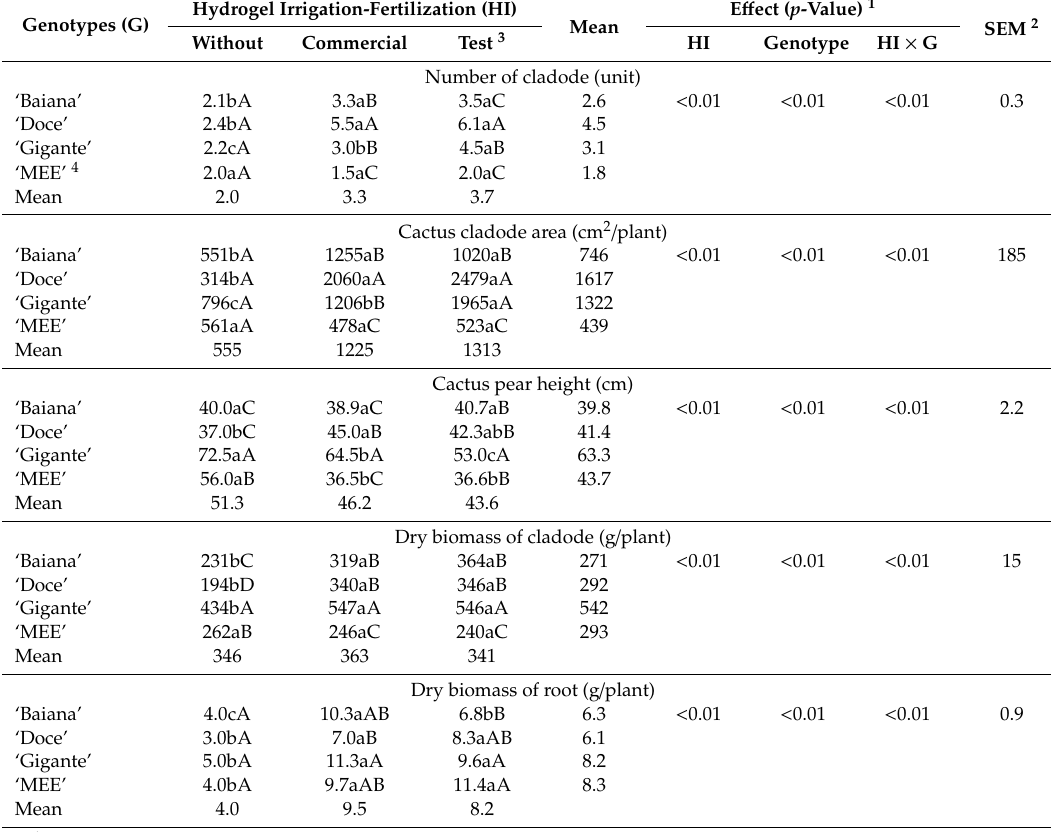
Figure 3. Scanning electron micrograph (SEM) of lyophilized hydrogel from babassu coconut mesocarp reticulated with acrylamide. Table 2. Growth characteristic of four cactus pear genotypes under different forms of hydrogel irrigation-fertilization.